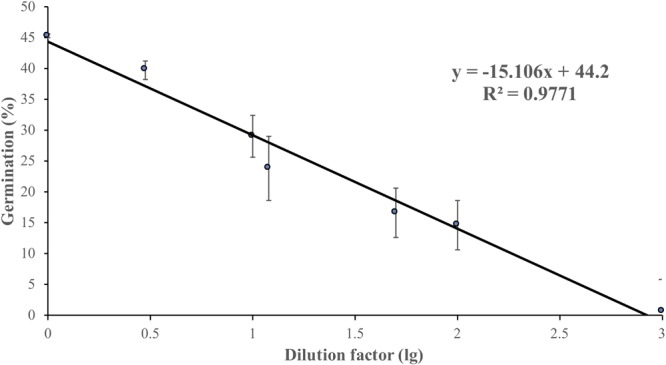
Zoosporic germination of Phytophthora erythroseptica versus zoospore exudate (ZE) dilution factors. ZE extracted from 5 × 105 spores/ml was serially diluted by the dilution factors (X-axis). A linear regression between dilution factor (X) and germination (Y) was established as follows: Y = -6.61X + 44.11, R2 = 0.625. Each data point was the average of two independent trials with three replicates in each trial. The standard error of the coefficient of X is 0.72, and the coefficient is significant at the 1% level. The standard error of the coefficient of the constant term is 2.51, and the coefficient is also significant at the 1% level.